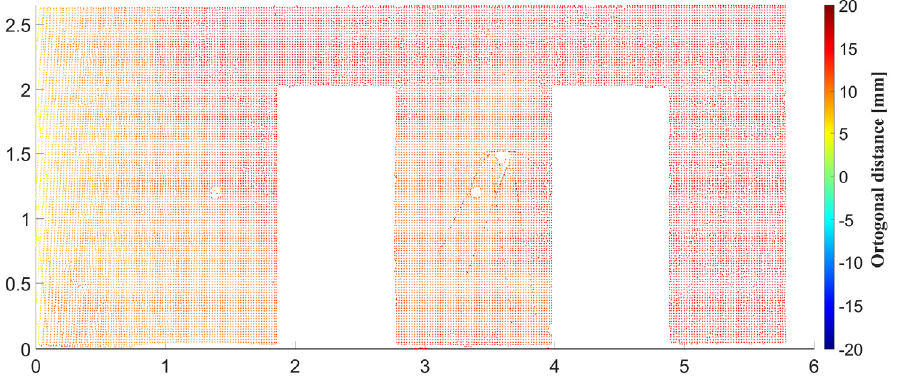
Figure 17. Deviation map, the wall no. 7—comparison of the IFC plane and the segmented point cloud.